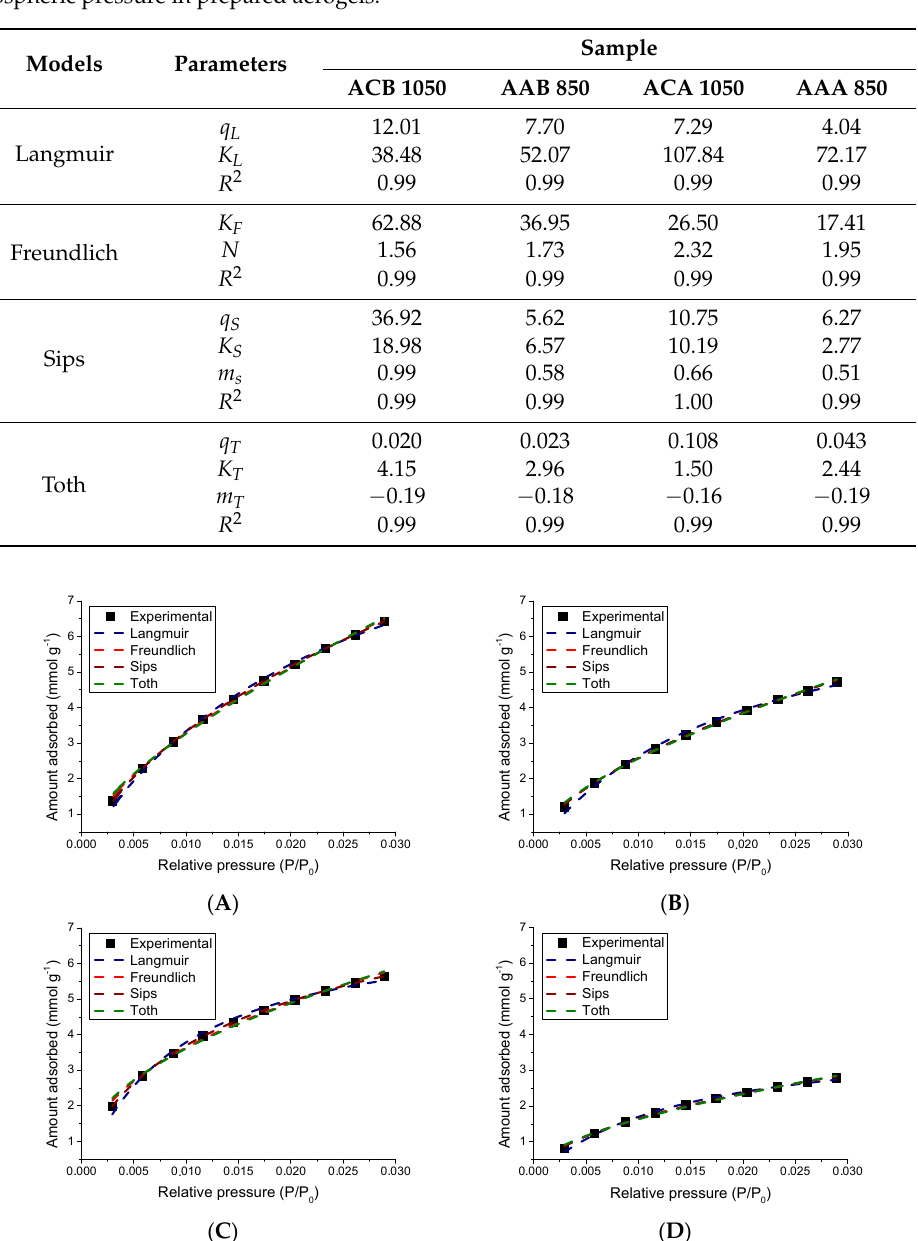
Table 4. Parameters of the Langmuir, Freundlich, Sips, and Toth isotherms for the adsorption of CO 2 at atmospheric pressure in prepared aerogels.